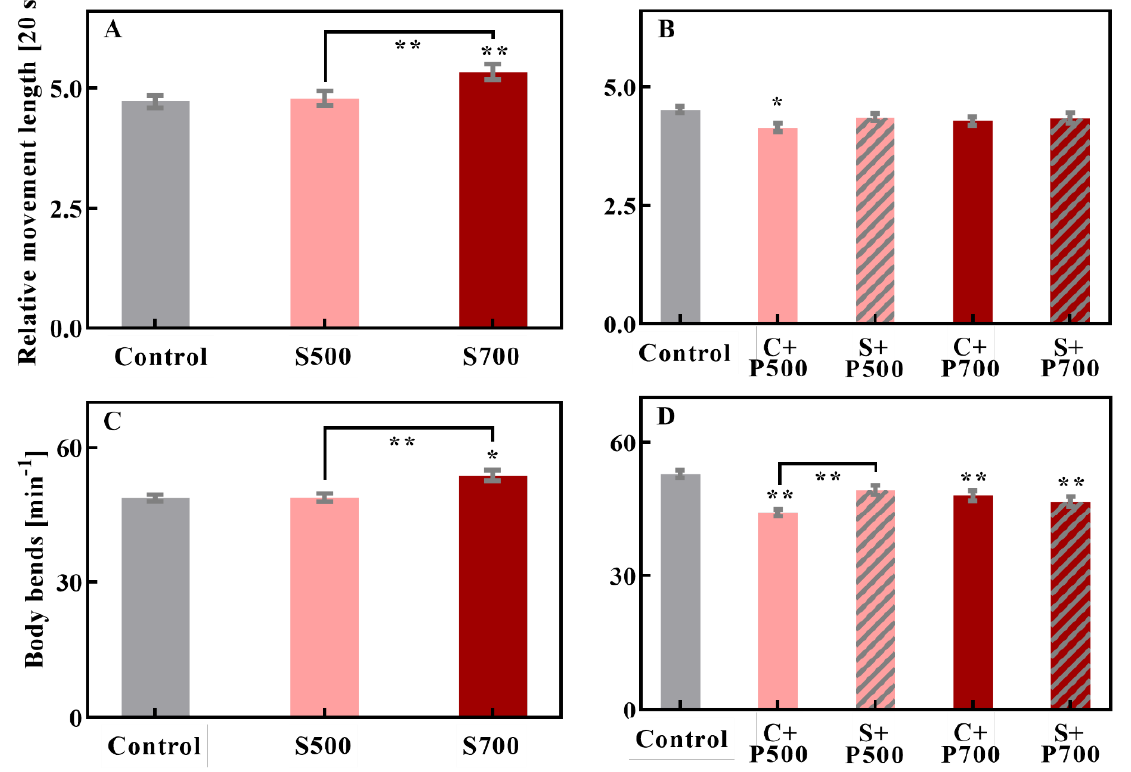
Figure 5. The autonomic behaviors of S500 and S700. Test 1: Exposure to the supernatant for 12 h ( A , C ). Test 2: Exposure to the supernatant for 12 h with the subsequent addition of washed particles ( B , D ). After exposure, the relative movement length ( A , B ) and body bend ( C , D ) were determined. * p < 0.05, ** p < 0.01.